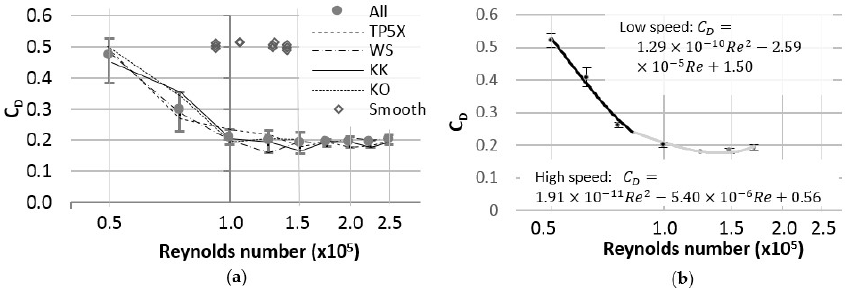
Figure 3. ( a ) Coefficient of drag as a function of Reynolds number for non-rotating balls; ( b ) Drag coefficient and empirical fits for KK (with spin). Error bars indicate the standard deviation of